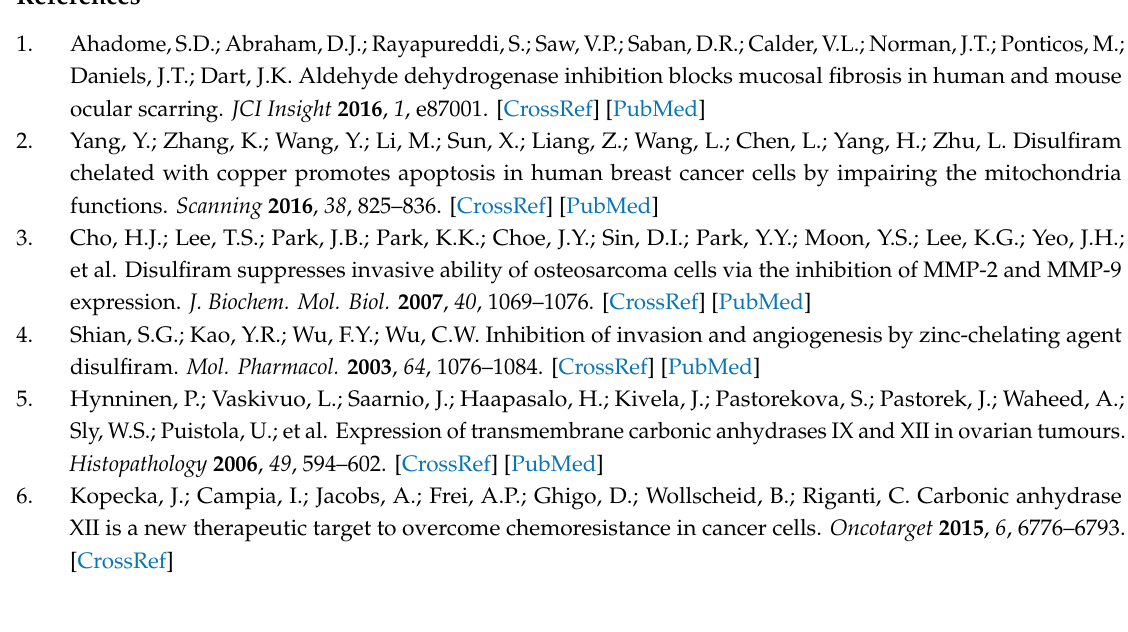
Supplementary Materials: The following are available online, Supplementary Figure S1. Cell viability of DSF-treatedA549cells. SupplementaryFigureS2. Thee ff ectofDSFonthelocalizationofAE2inAE2-overexpressed HEK293T cells. Supplementary Figure S3. Calibration curve of intracellular pH change (ratio) of MDA-MB-231 and MCF-7